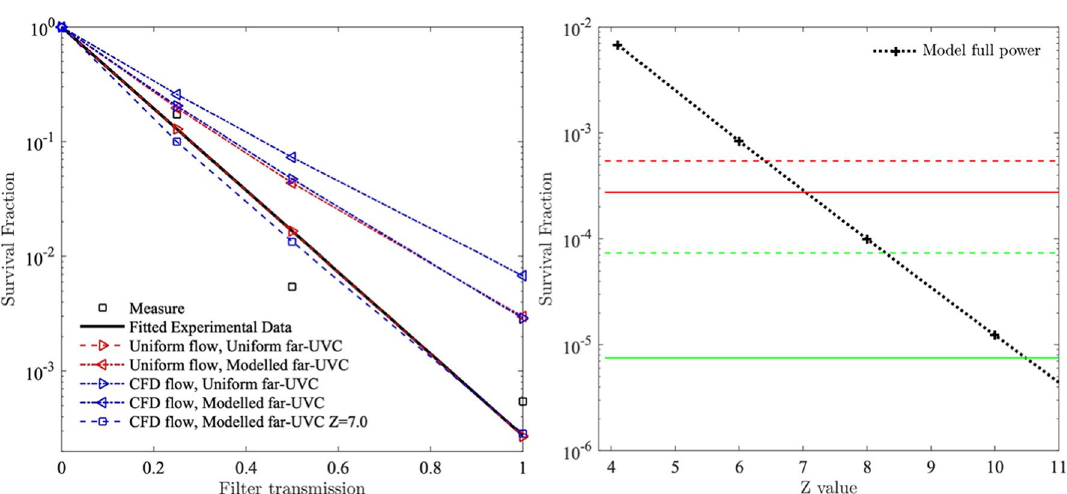
Figure 4. Left: Survival fractions as a function of filter transmission for HCoV-229E. A transmission of 1 assumes no additional filtration was installed in the lamp-chamber system. All of these modelling results utilized the previously calculated Z value of 4.1 cm 2 mJ − 1 except for the condition with Z = 7.0 cm 2 mJ − 1 which is the predicted correct value of Z using the model. Transmissions of 0.5 and 0.25, respectively, represent 50% and 75% attenuation of the far-UVC lamp intensity due to installation of additional 222 nm-absorbing polymer films. Right: Survival fractions estimated for varying Z values predicted by the model. Comparison against measured data for HCoV-229E (red) and HCoV-OC43 (green). Dashed line: measured data survival fractions. Solid line: fitted data survival